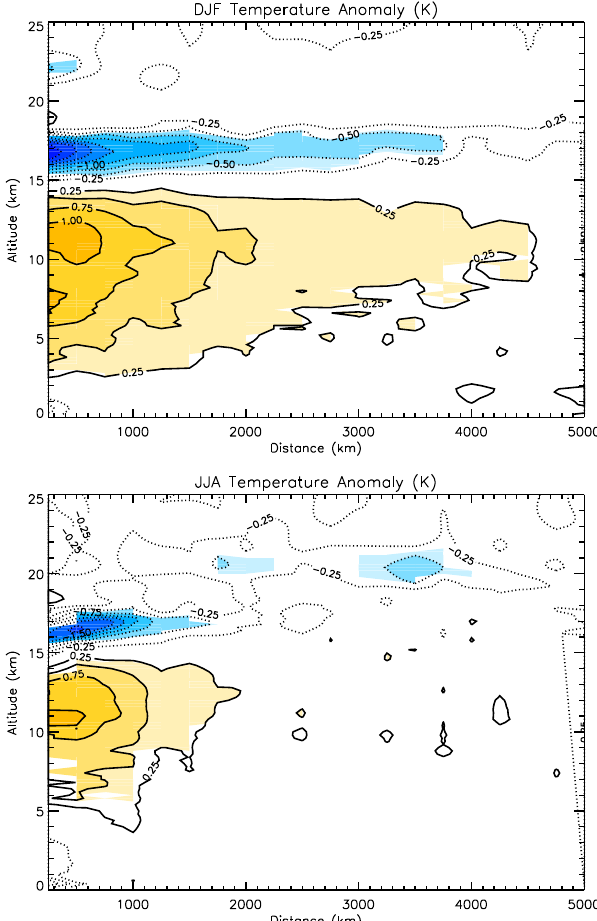
Fig. 7. Temperature anomaly contoured as a function of distance between CloudSat and COSMIC GPS measurements (within ± 6 hours) and altitude, corresponding to events with deep convective cloud top pixels above 17 km, for (top) DJF and (bottom) JJA. Anomalies that exceed the 99% significance level appear in color. Orange and red colors correspond to positive anomalies, blue colors correspond to negative anomalies.